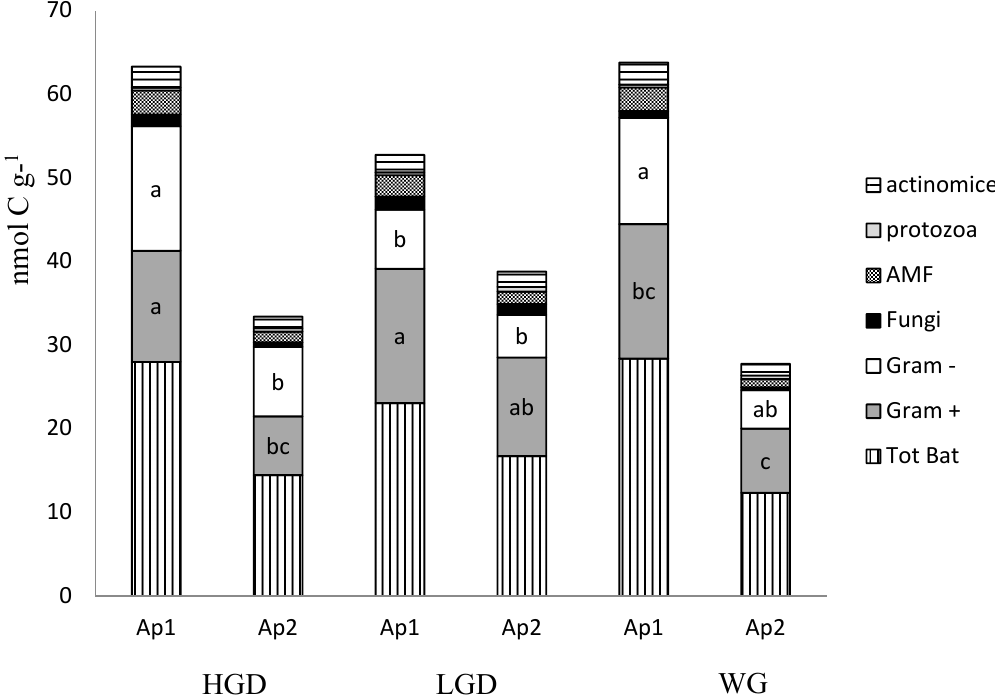
Figure 1. Main microbial community estimated by Ester-linked phospholipid fatty acids (PLFA) in soils with a high (HGD) and low (LGD) geese density, and control vineyard (WG). Different soil horizons are compared (Ap1, Ap2) of the vineyard. For each histogram, different letters significantly differ for p < 0.05.